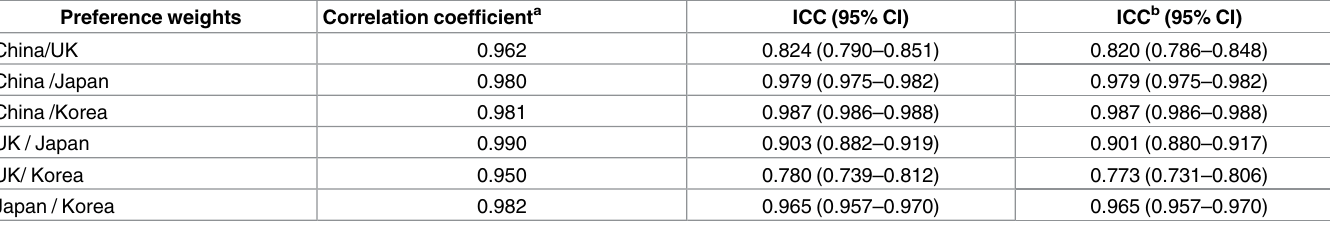
Table 3. Pearson correlation coefficients and ICCs between China, UK, Japan and Korea